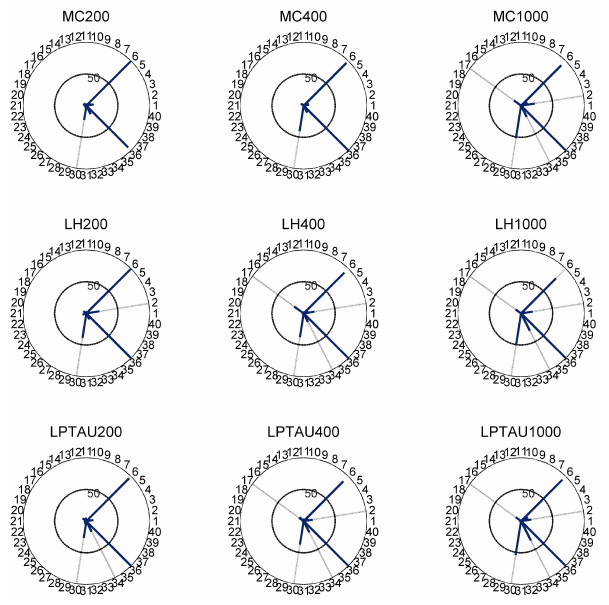
Fig. 2. The sensitivity score of sensible heat given by SOT. The length of needles, which range from 0 to 100, represents the sensi- tivity score of each parameter.